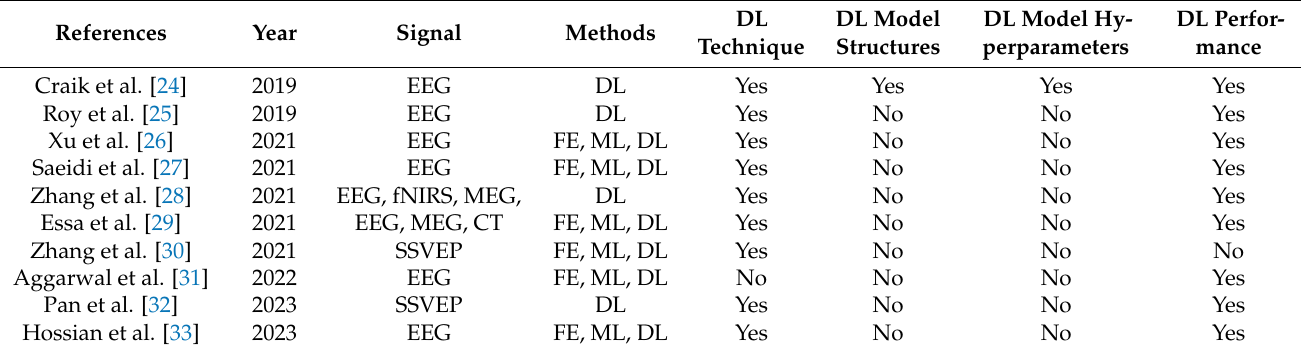
Table 1. Reviews and surveys on using deep learning models to classify steady-state visual evoked potentials (SSVEPs). Here, EEG represents electroencephalography, fNIRS represents functional near- infrared spectroscopy, MEG represents magnetoencephalography, FE represents feature extraction, ML represents machine learning, and DL represents deep